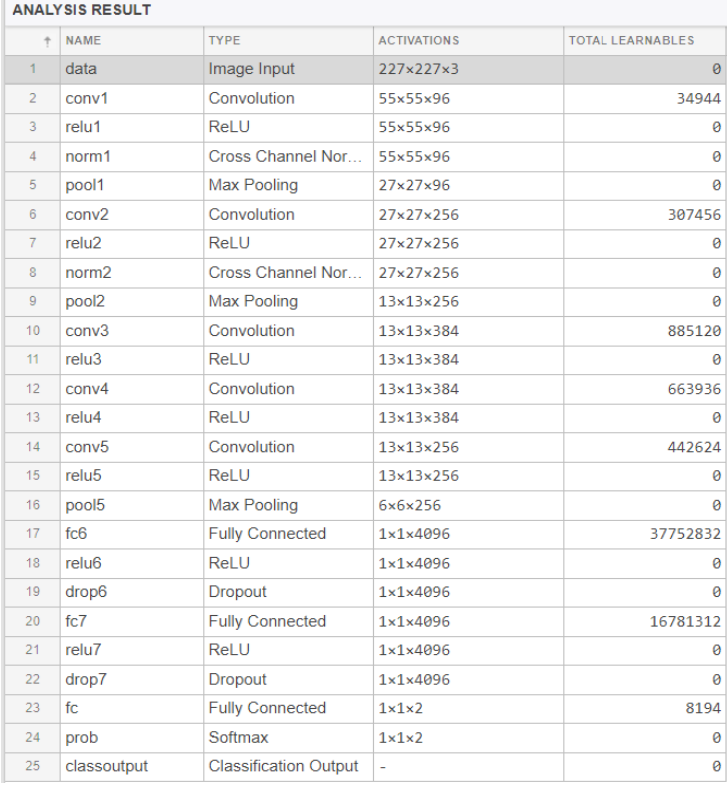
( b ) Figure 15. GPS coordinate extraction with image preprocessing: ( a ) raw/unprocessed hydroacoustic image and ( b ) preprocessed image optimized for optical character recognition (OCR). Generated output: N035 . 46.033 ↵ W078 . 40 . 734 ↵↵. 3. Results 3.1. Autonomous Vehicle Performance Autonomous water vehicles were deployed into multiple water bodies for a variety of weather conditions, spanning seasons from mid-summer to early winter. The majority of trials were conducted on Lake Raleigh, a 75- acre lake located on North Carolina State University’s Centennial Campus, to evaluate the boats’ manual and autonomous navigational capabilities and confirm the herbicide dispersal system functionality. 3.1.1. Autonomous Navigation With the marine propulsion system, prototypes achieved speeds up to 2.3 m/s and were able to navigate in the presence of moderate wind (4.5 m/s, 10 mph), light rain, and choppy surface water conditions. An iterative controller tuning process was completed to ensure high-performance